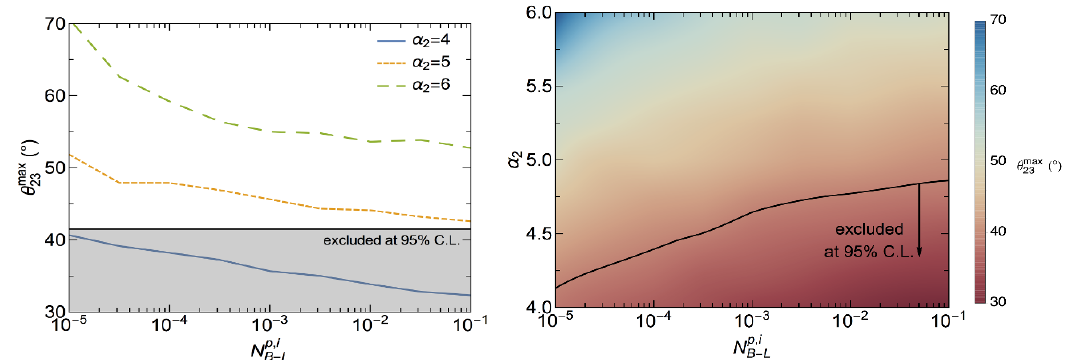
Figure 5 . Left panel: upper bound on (cid:18) 23 as a function of N p ; i (cid:11) 2 . The gray band shows the current 2 (cid:27) experimental constraints (cid:18) 23 & 41 : 5 (cid:14) [8]. Right panel: 95% C.L. constraint in the plane (cid:11) 2 versus N p ; i